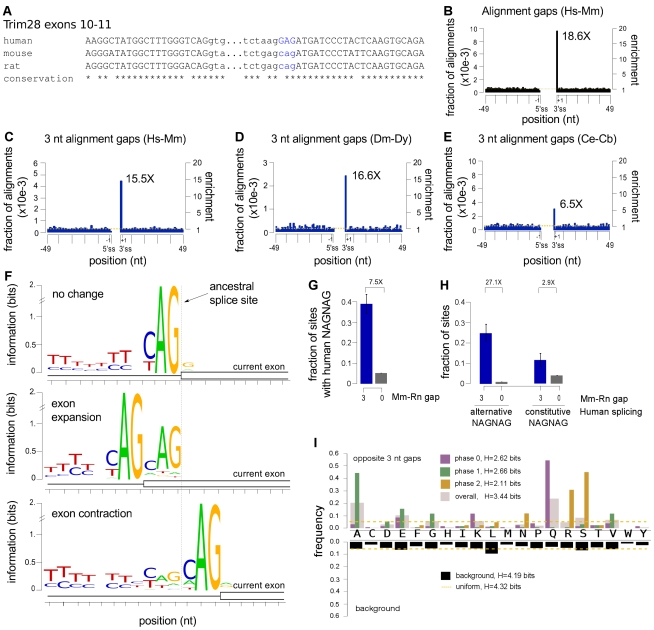
NAGNAGs are associated with accelerated protein evolution at exon-exon boundaries.(A) Alignment of portions of exons 10 and 11 of TRIM28 gene from three mammals, illustrating a shift in the upstream boundary of exon 11 between human and rodents. Exonic sequence shown in capitals; intronic sequence in lower case. (B) Gain/loss of exonic sequence between human and mouse occurs preferentially at 3′ splice sites (p<10−6, permutation test). The fraction of aligned orthologous human and mouse exons with gaps at each position is shown; the background level (mean fraction across the indicated region excluding the 3′ splice site) is shown by the dotted yellow line; the right-hand axis shows enrichment relative to this background. (C) As in (B), but restricted to gaps of length three bases. Preferential occurrence at 3′ splice sites was highly significant (p<10−6, permutation test). (D) Similar to (C), but based on alignments of orthologous D. melanogaster and D. yakuba exons. Preferential occurrence at 3′ splice sites was highly significant (p<10−6, permutation test). (E) Similar to (C), but based on alignments of orthologous C. elegans and C. briggsae exons. Preferential occurrence at 3′ splice sites was highly significant (p<10−6, permutation test). (F) Residual NAG motif at exons whose boundaries changed in the rodent lineage. Orthologous mouse and rat exons were classified as unchanged (top), expanded by three bases (middle), or contracted by three bases(bottom) based on comparison to an outgroup (human, cow, chicken, or Xenopus laevis), aligned to the inferred location of the ancestral 3′ splice site (dotted line). Information content of each position is shown relative to a uniform background composition. (G) Exons whose 3′ splice site boundaries differ by three bases between rat and mouse are 7.5 times as likely to have a NAGNAG in the human ortholog as exons whose boundaries did not change (p-value for difference<10−24 by Fisher's exact test). Error bars indicate the 95% binomial confidence interval. (H) Rodent exons orthologous to alternatively spliced human NAGNAG exons (left) are much more likely to exhibit exon boundary changes of three base pairs than those orthologous to constitutively spliced human NAGNAGs (right) (p-value for difference<10−10 by Fisher's exact test). Blue and gray bars in (H) represent subsets of blue and gray bars in (G), respectively. Error bars indicate the 95% binomial confidence interval. (I) Frequency of encoded amino acids that occur opposite gaps at the 3′ splice site in alignments of human and mouse exons is plotted above, overall (pink) and separately by the phase of the upstream intron (i.e., the number of bases, if any, in the last incomplete codon of the upstream exon); amino acid frequency at background positions (4 codons downstream of the 3′ splice site) is shown below. The Shannon entropy (a measure of randomness) of each amino acid frequency distribution is also shown.